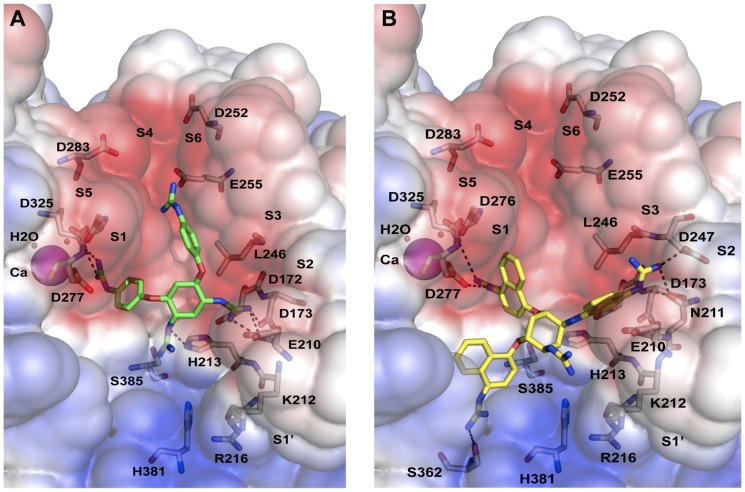
Putative binding modes of compounds 1g and 1o in the active site of hPC6.hPC6 is depicted as a molecular surface colored by electrostatic potential (red – regions of negative potential, blue – regions of positive potential), selected residues of the S1–S6, S1′ sub-pockets and catalytic triad are shown as sticks. The Ca2+ cation close to the active site is shown as a magenta sphere (labelled as Ca) and the coordinated waters as small red spheres (labelled as H2O). The location of sub-pockets S1–S6 and S1′ are indicated. Electrostatic/hydrogen bonds/polar contacts are indicated by black dashed lines. (A) Binding mode of compound 1g (green colored sticks). The four guanidino moieties are located in S1, S2 and S4 sub-pockets and near the catalytic triad (D172, H213, S385). (B) Binding mode of compound 1o (yellow colored sticks). The four guanidino moieties are located in the S1, S2 and S3 sub-pockets and near the catalytic triad (D172, H213, S385).